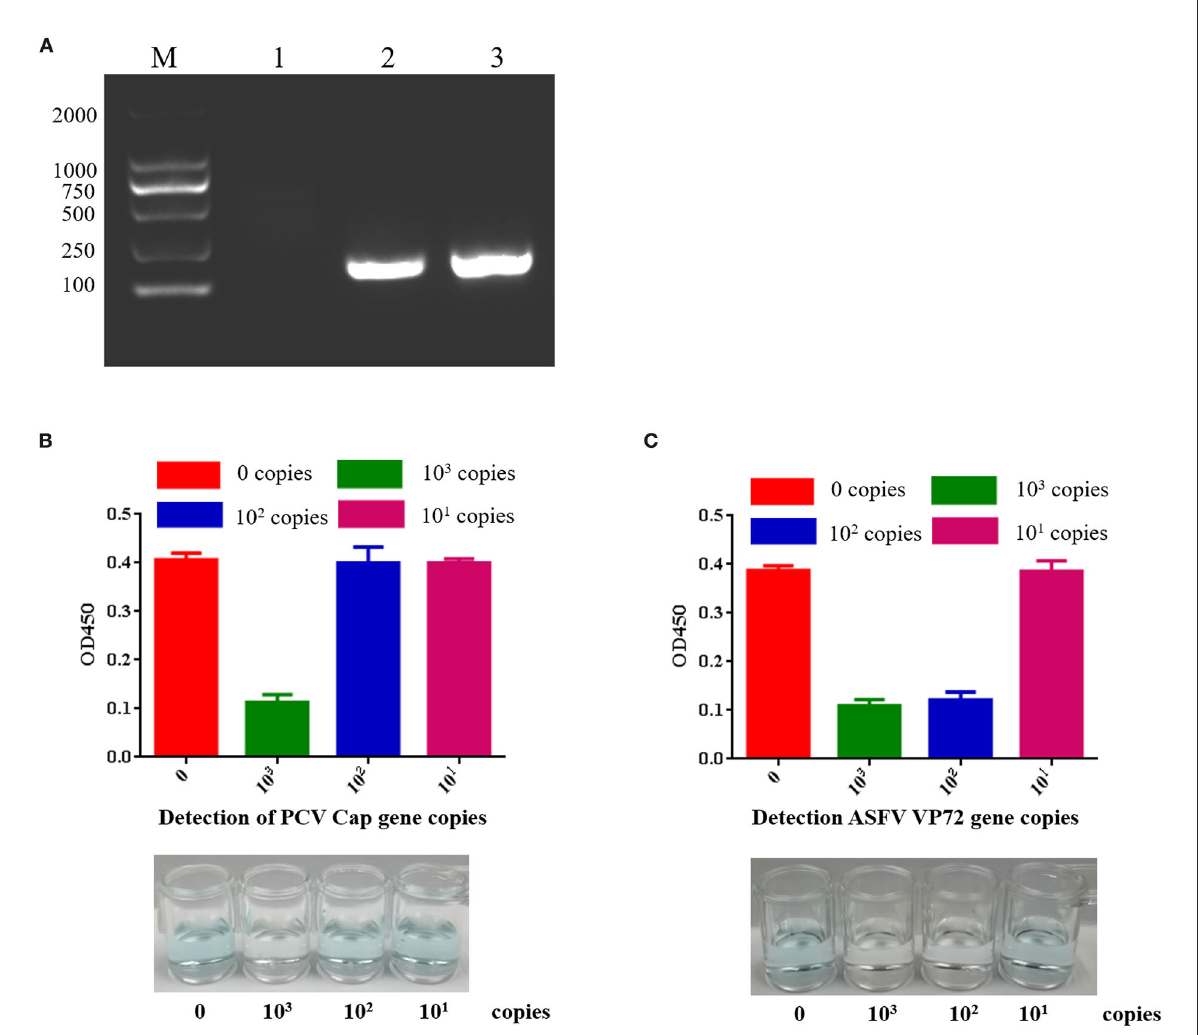
FIGURE4 Sensitivity of PCV2 and ASFV DNA detection by CRISPR-Cas12a combined with G-quadruplex. (A) RPA amplified target DNA. Lane M: 2000 DNA ladder; Lane 1: negative control; Lane 2: RPA amplification of PCV2 target sequence; Lane 3: RPA amplified ASFV target sequence. (B) PCV2 DNA detection by CRISPR-Cas12a combined with G-quadruplex. The least copies of this method were 10 3 copies. (C) ASFV DNA detection by CRISPR-Cas12a combined with G-quadruplex. The least copies of this method were 10 2 copies.